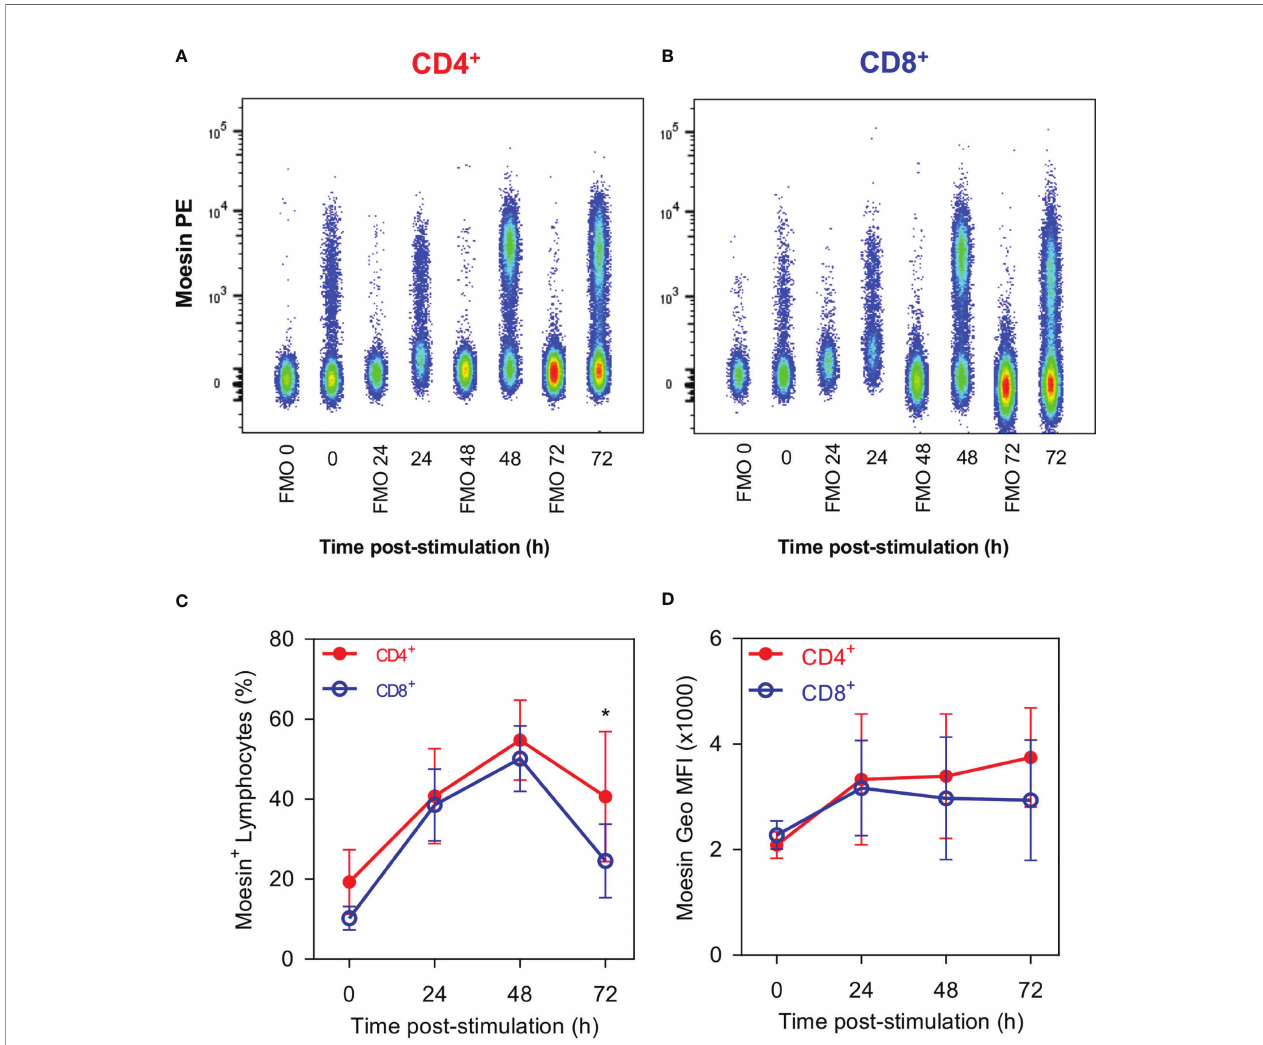
FIGURE 3 | CD4 + and CD8 + Lymphocytes show similar moesin expression. Splenocytes were stimulated with anti-CD3 and anti-CD28 mAbs; cells were harvested at the indicated time points and stained with anti-CD4, anti-CD8, anti-moesin, Ghost Dye Red 780, and immediately analyzed by fl ow cytometry. CD4 + and CD8 + gates were de fi ned as described in Figure 1 . Representative analysis of moesin expression kinetics in (A) CD4 + and (B) CD8 + T cells; (C) percentages of CD4 + moesin + and CD8 + moesin + cells and (D) moesin expression in each cell subset after activation. Mean and SD from 2 independent experiments with 3 mice per group are shown in C and D; data were analyzed using one-way ANOVA followed by Bonferroni ’ s multiple comparison test between CD4 + (Red full circles) and CD8 + (Blue open circles) at each time point. *p <